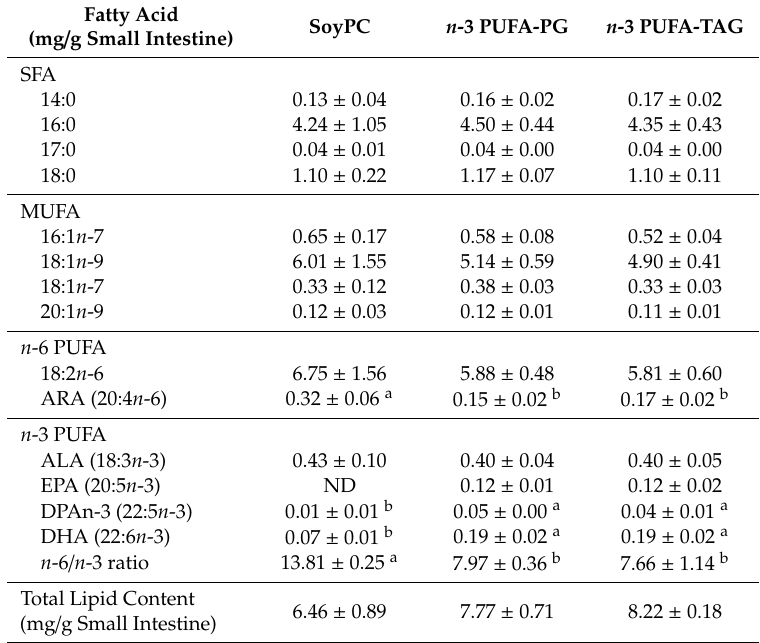
Table 4. Total lipid content and fatty acid composition of the small intestine in KK- A y mice fed experimental